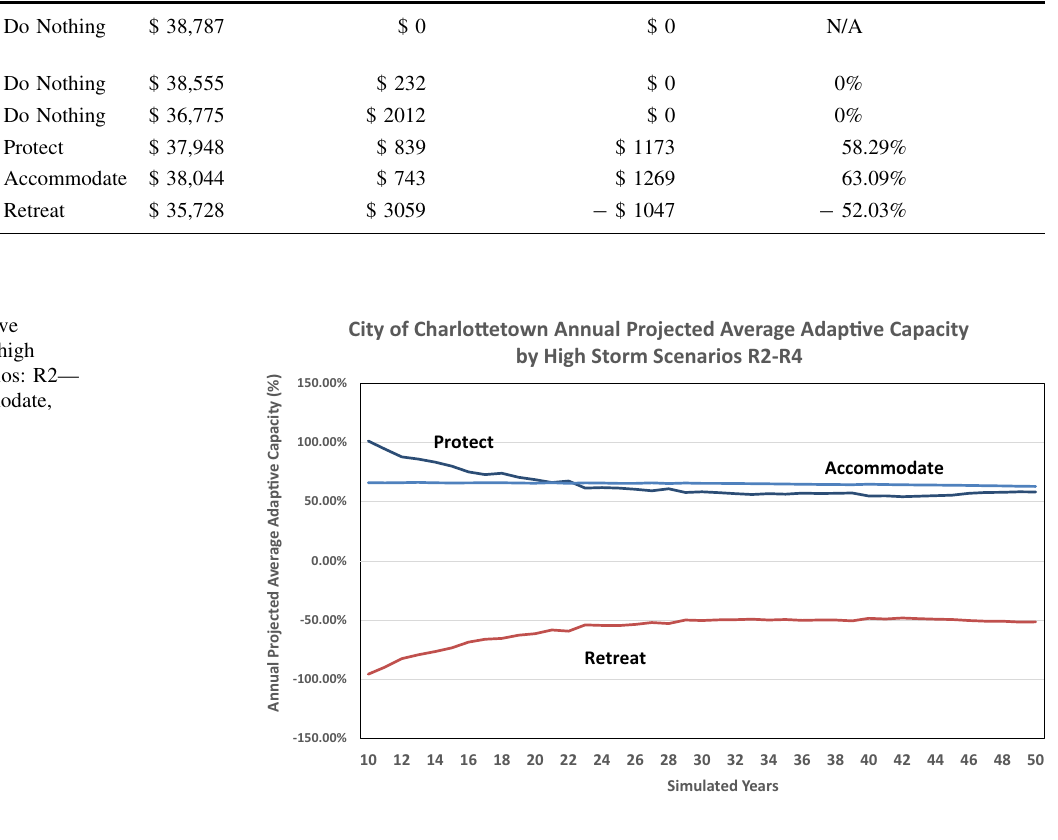
Table 9 Asset-based indicators for average annual Vulnerability, Resilience, and Adaptive Capacity over the 50-year planning period Scenario Storm